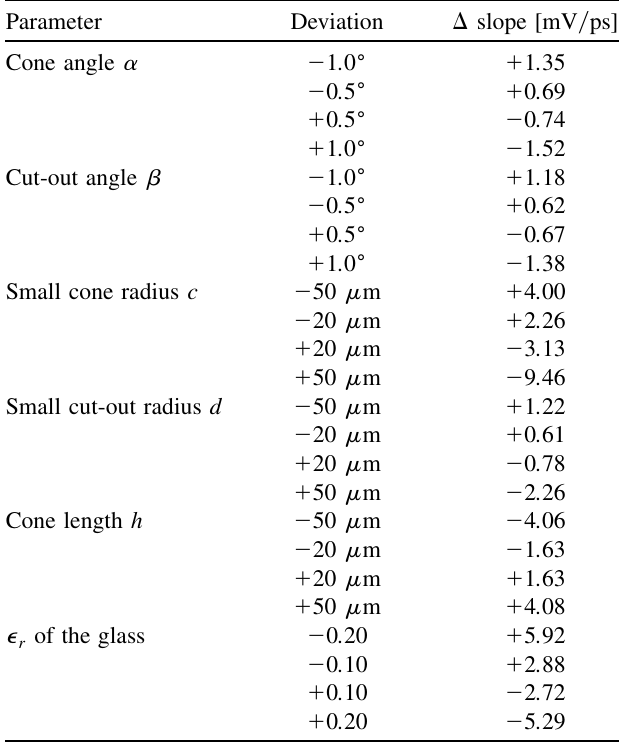
HIGH BANDWIDTH PICKUP DESIGN FOR BUNCH . . TABLE III. Computed change of the slope with quadratic fit based on the tolerance study results. Parameter Deviation